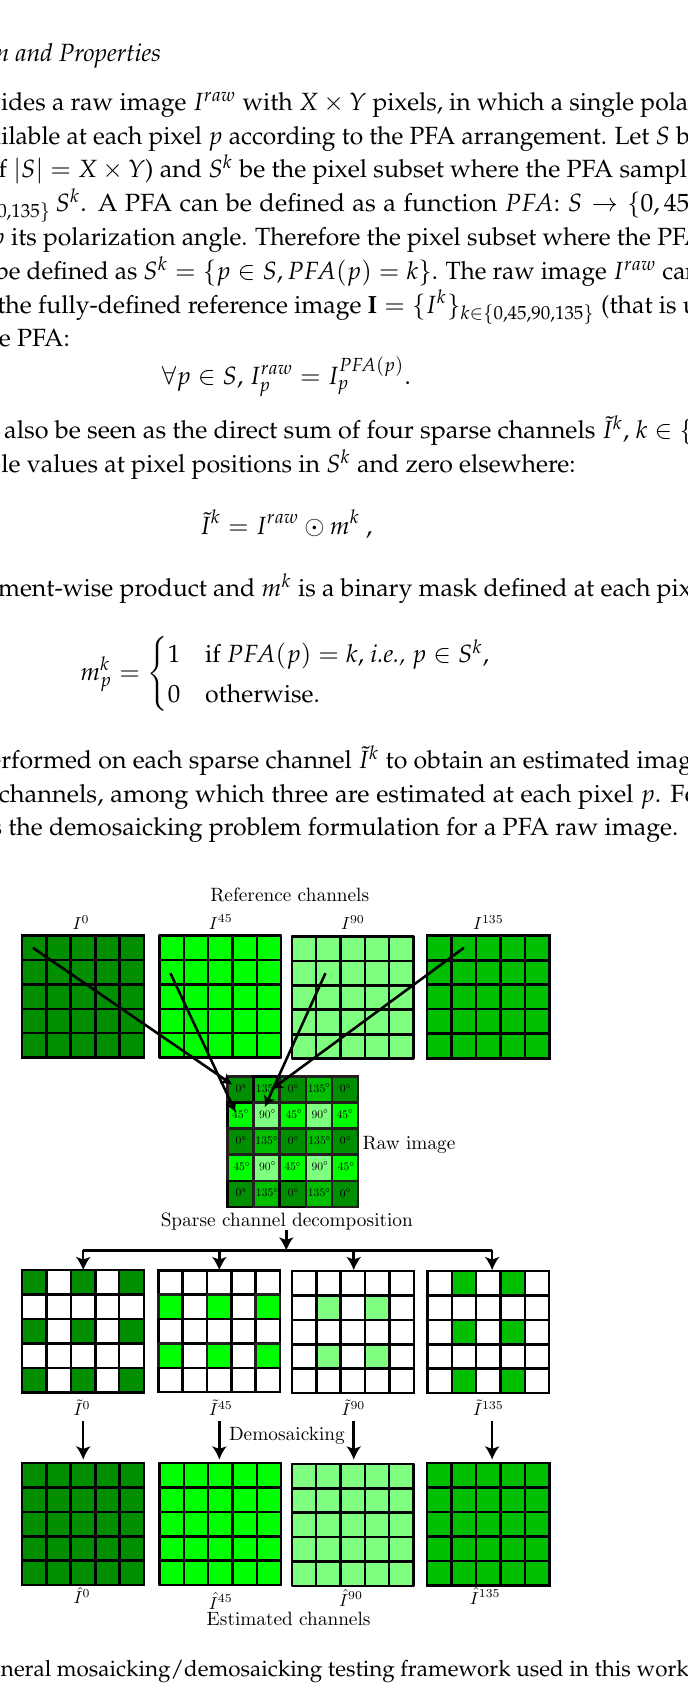
Figure 4. General mosaicking/demosaicking testing framework used in this